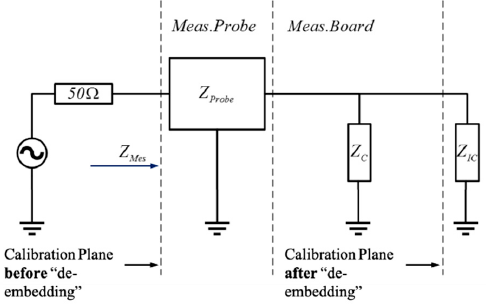
Figure 9. De-embedding principle [26].